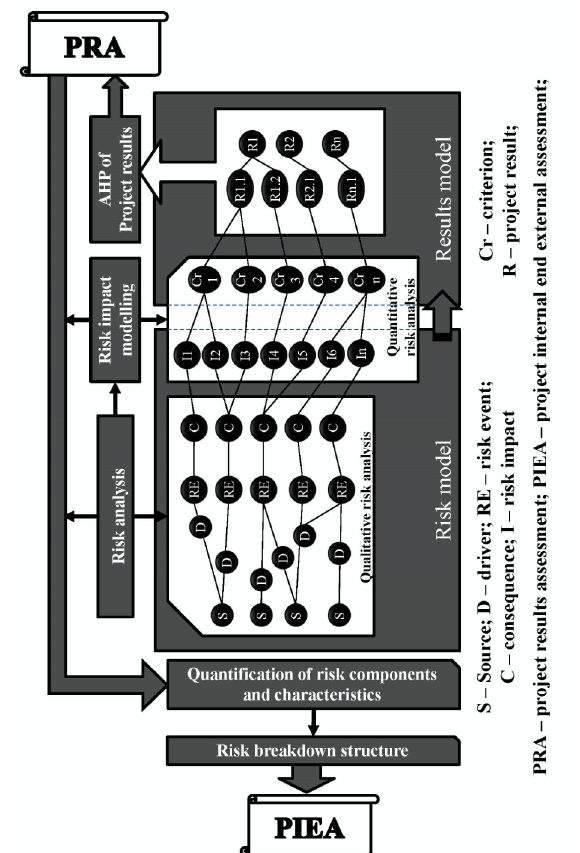
Fig. 4 . Illustration of project assessment